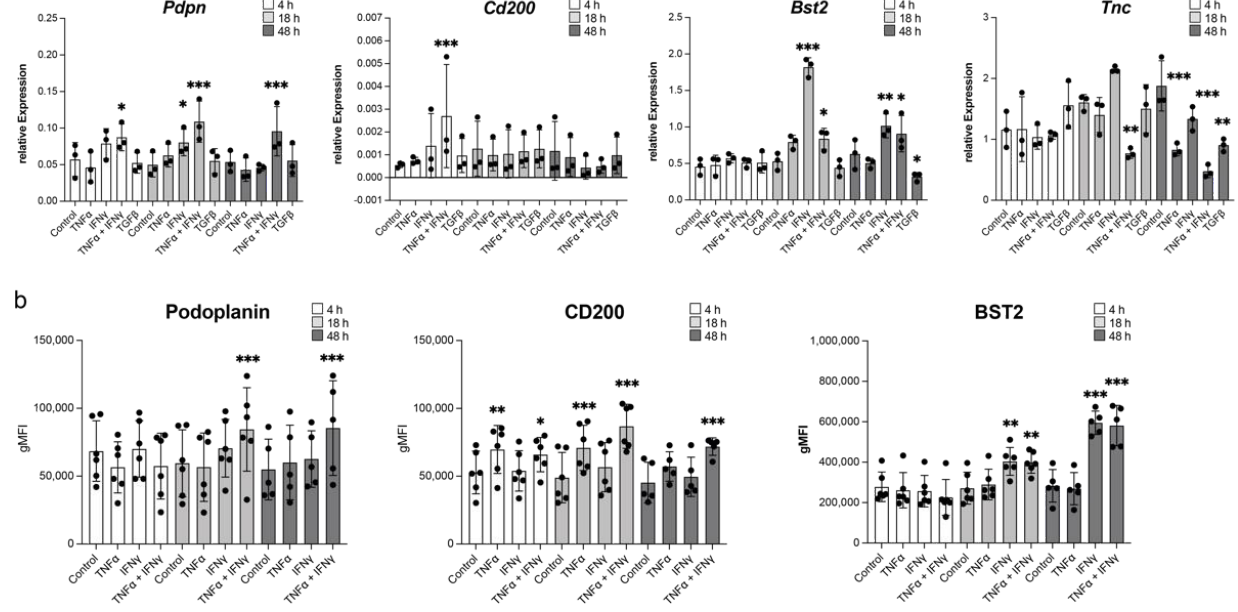
Figure 3. Induction of selected genes in primary LN LECs by cytokines. ( a ) Induction of Pdpn , Cd200 , Bst2 , and Tnc expression in LN LECs treated with cytokines for 4 h (white), 18 h (light-gray), or 48 h (dark-gray) measured by qPCR. Pooled data from three experiments, presented as relative expression normalized to Rplp0 at each time point. Individual values, mean, and SD are shown. ( b ) Induction of podoplanin, CD200, and BST2 in LN LECs treated with cytokines for 4 h (white), 18 h (light-gray), or 48 h (dark-gray) measured by flow cytometry. Pooled data from six experiments, gMFI of each sample, mean, and SD are shown. * p < 0.05, ** p < 0.01, *** p < 0.001, RM one-way ANOVA with Geisser–Greenhouse correction and Dunnett’s multiple comparisons test comparing the means of each time-point to the respective control.